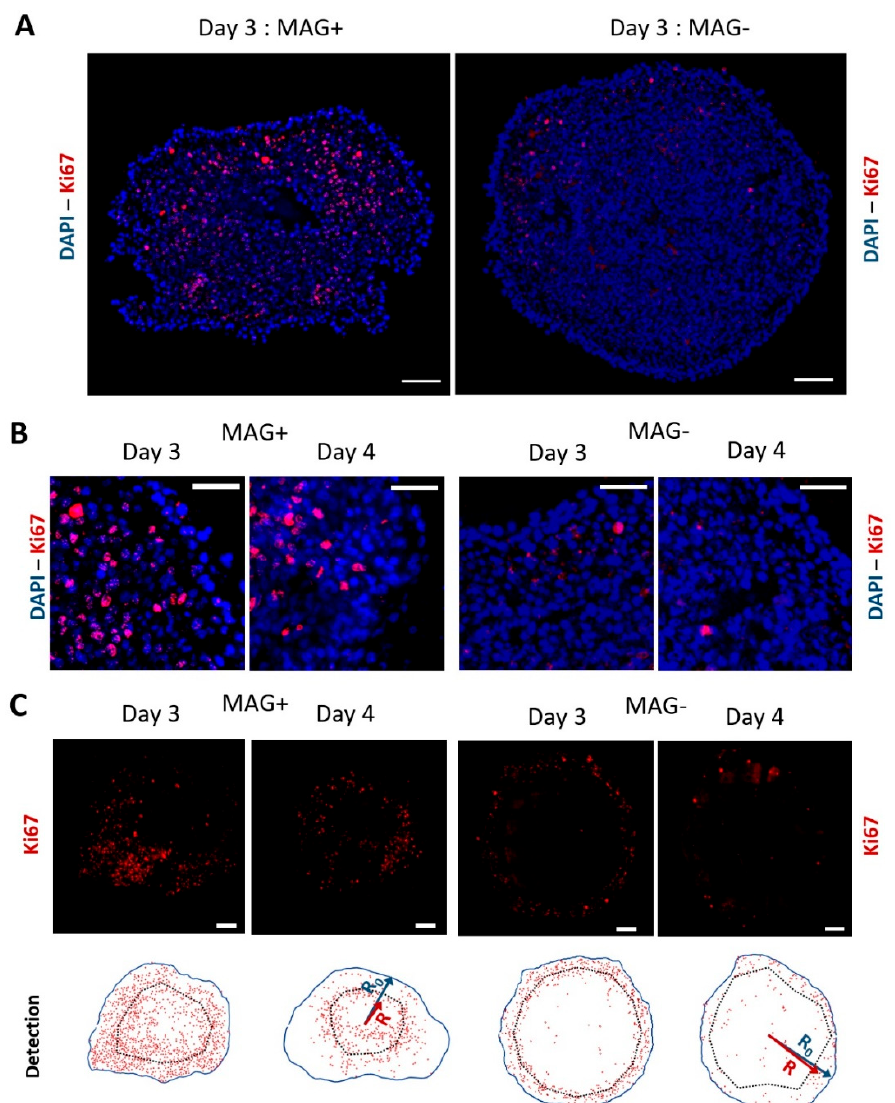
Figure 2. Ki67 labeling and detection at day 3 and day 4 for MAG+ and MAG − spheroids. ( A ) Typical fluorescence staining of compressed (MAG+) or left free (MAG − ) CT26 spheroids for two days. The nuclei are labeled in blue (DAPI), and the proliferation marker Ki67 is shown in red. The proliferative nuclei of the MAG − spheroids are located on the edges, whereas the images evidence proliferation toward the center of the MAG+ spheroid. Scale bar= 100 µm. ( B ) Close up images at the edges of MAG+ and MAG − spheroids cultured for two and three days after formation (day 3 and day 4, respectively). Nuclei are labeled in blue and Ki67 in red. Scale bar = 50 µm. ( C ) Other Ki67 fluorescence images (in red) at day 3 and day 4 for MAG+ and MAG − spheroids. The bottom analysis shows typical detection of the Ki67-positive nuclei for the different conditions. The red dots represent the Ki67-positive nuclei, the blue line the edges of the spheroid (distance from center R0), and the dashed line represents the average localization of the Ki67-positive nuclei (distance from center R) for each sample. Scale bar = 100 µm.